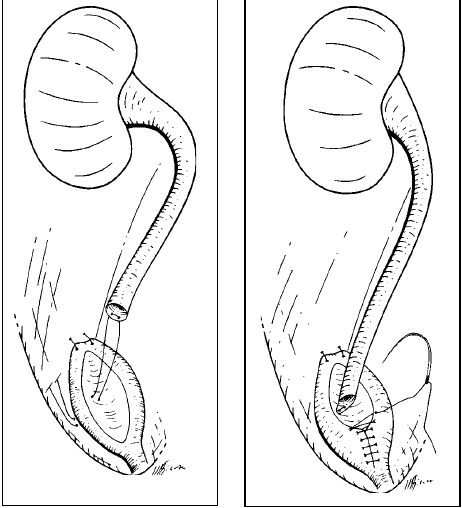
Figure 1 - Ureteroneocystos- tomy in the rat. Left , , , , , Bladder dome fixed to psoas muscle and inverted “U” stitch transfixing bladder and ureteral walls. Right ,,,,, Ureter positioned inside the bladder, fixed to the posterior bladder